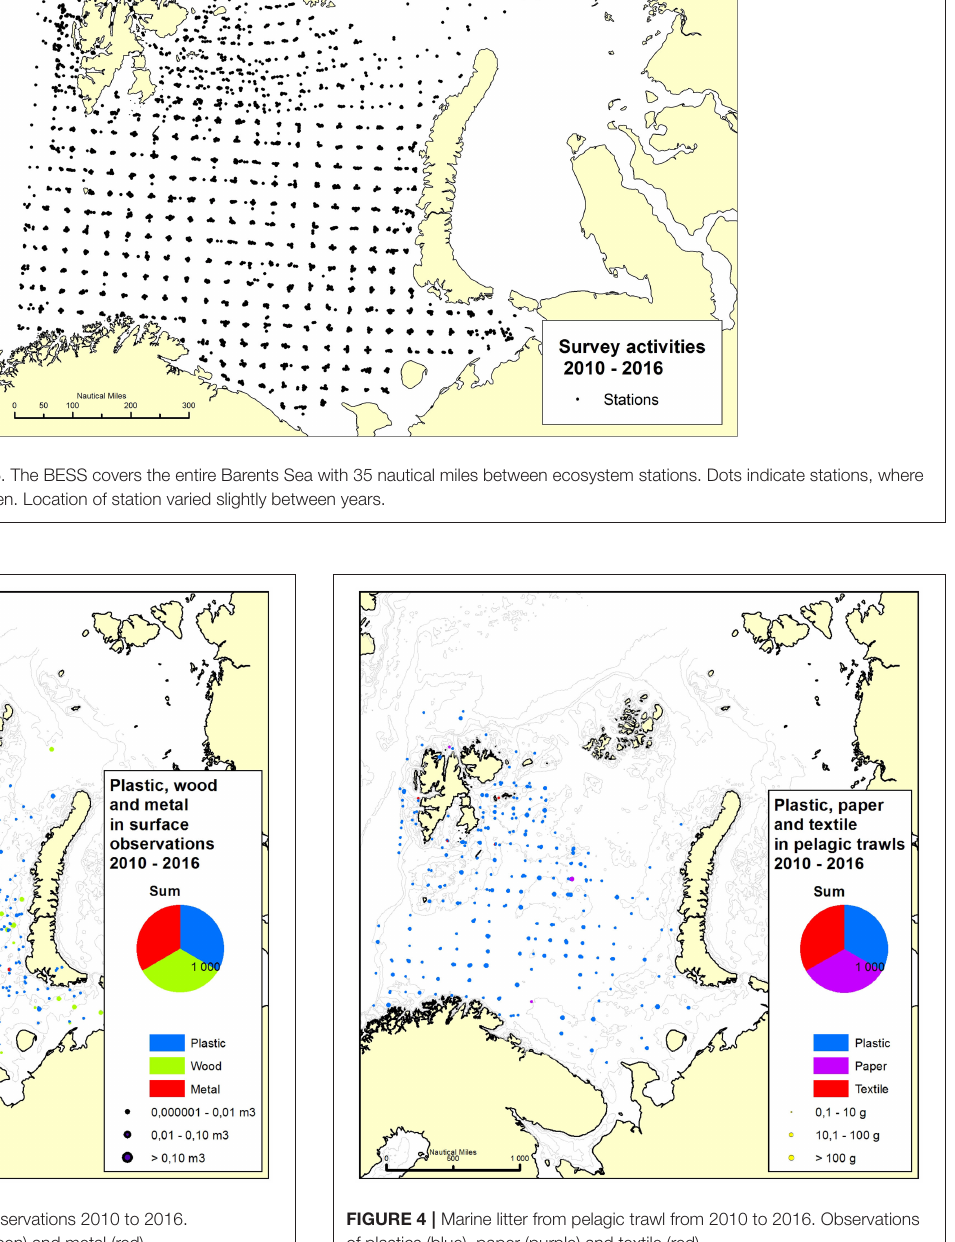
(0–60 m) and other equipment (more detail in Michalsen et al., 2011). All vessels use standard trawls and trawling procedures and data are comparable between vessels and